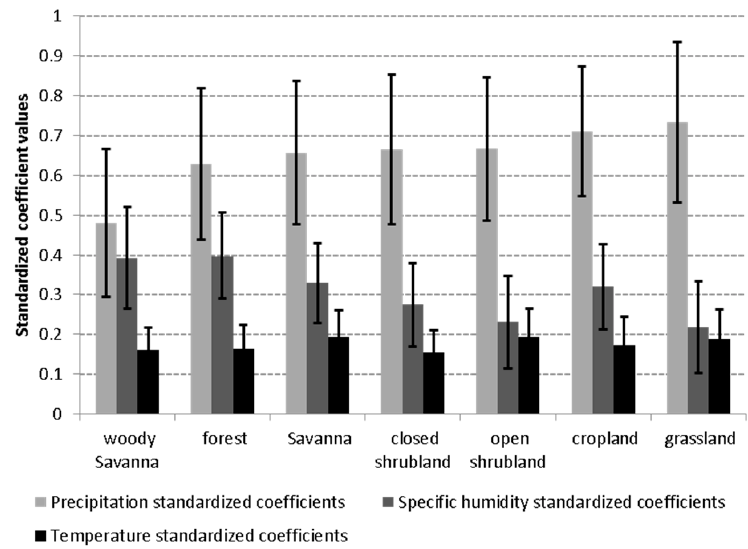
Figure 11. Mean absolute values of the standardized coefficients of the multivariate regression between NDVI and explanatory variables (precipitation, specific humidity and temperature) summarized for the land cover types. Error bars are ±1 standard deviation around the mean.